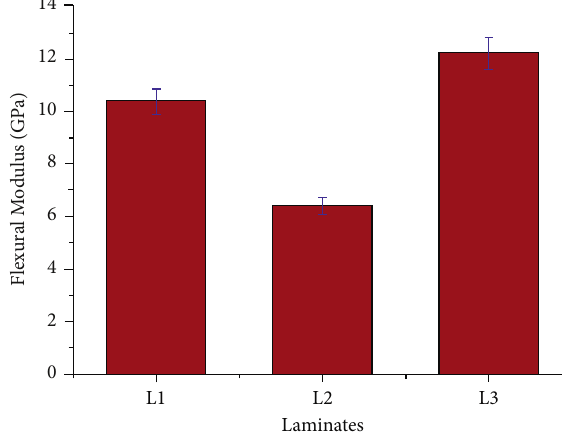
Figure 8: Representation of flexural modulus of different laminates.